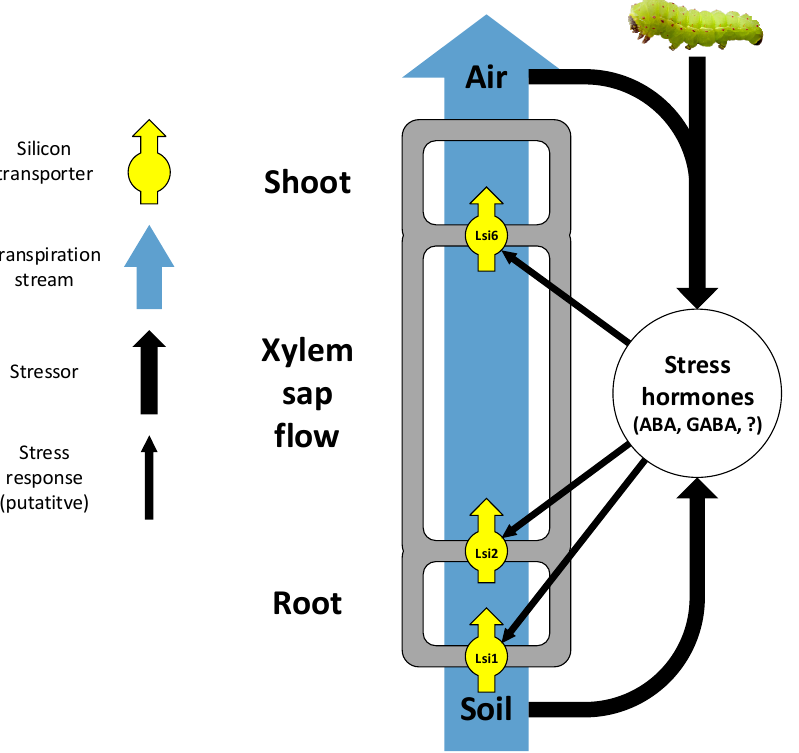
Figure 1. A simplified model of Si uptake from the soil to the shoot through the transpiration stream, including main transporters and responses to external factors.